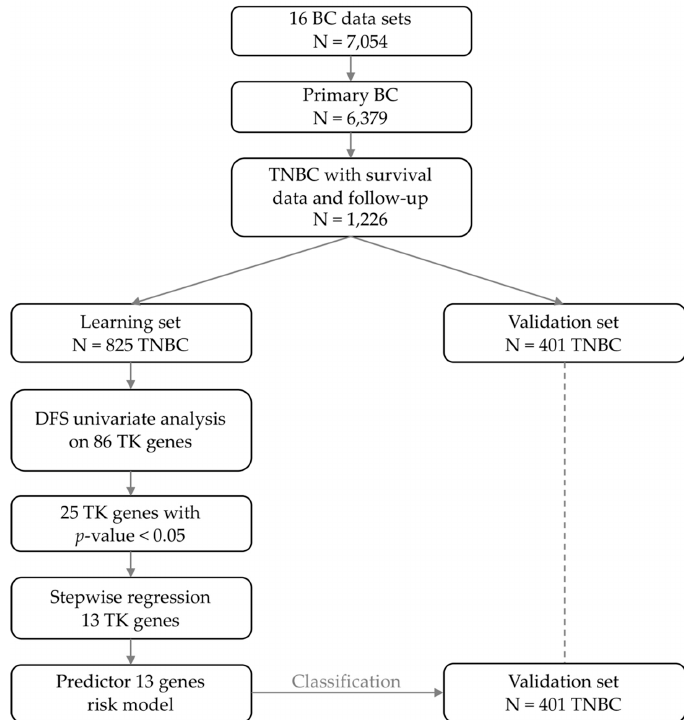
Figure 1. Flow diagram showing the different steps of analysis. Abbreviations: BC, breast cancer; TNBC, triple negative breast cancer; TK, tyrosine kinase; DFS, disease-free survival. Cancers 2019 , 11 , x FOR PEER REVIEW